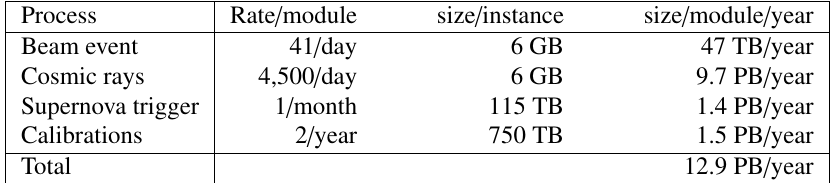
Table 1. Data sizes and rates for di ff erent processes in each far detector module. Uncompressed data sizes are given. As readouts will be self-triggering an extended 5.4 ms readout window is used instead of the 3ms for the triggered ProtoDUNE-SP runs. We assume beam uptime of 50% and 100% uptime for non-beam science.These numbers are derived from references [15] and